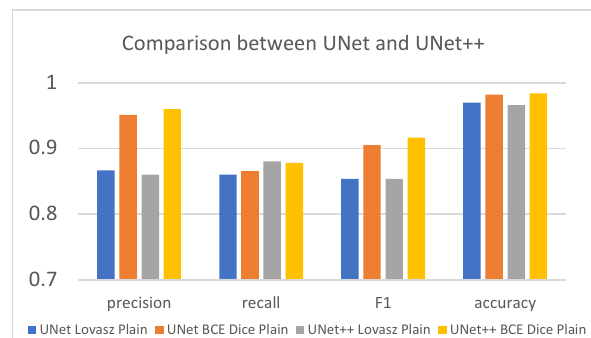
Figure 3: Effect of Data Augmentation (Data Aug) and Deep Supervision (Deep Sup) on UNet++ architecture when training using the Lovász Hinge Loss.